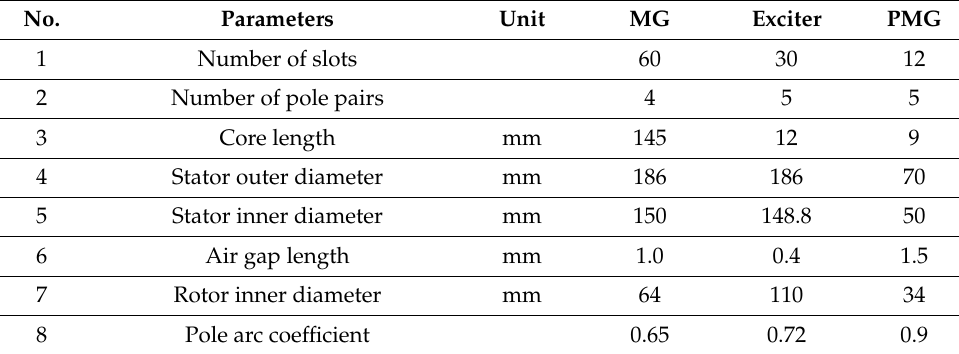
Table 4. RAT10k generator-related parameters.